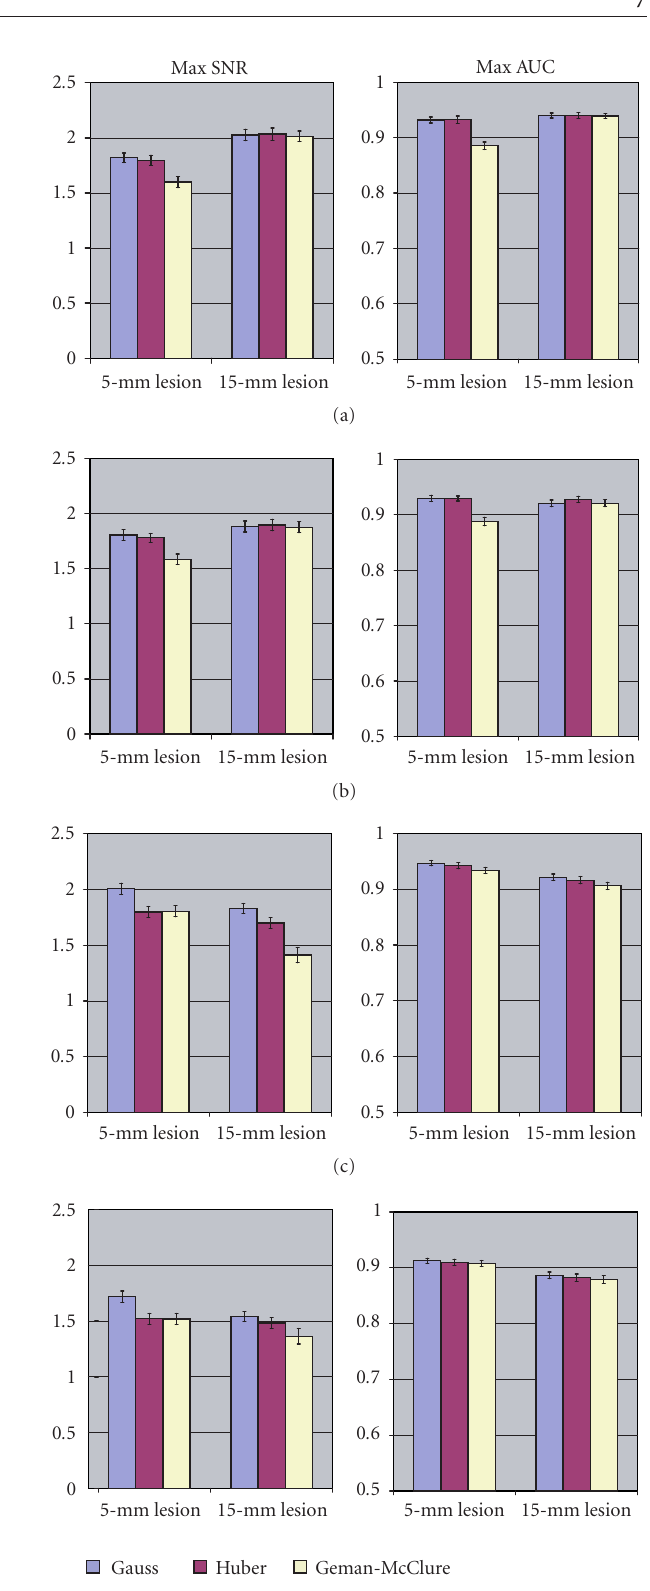
Figure 7: The maximum SNR and maximum AUC for detecting a lesion in di ff erent backgrounds. (a) Fixed background; (b) lumpy backgrounds in Figure 3(b); (c) lumpy backgrounds in Figure 3(c); and (d) lumpy backgrounds in Figure